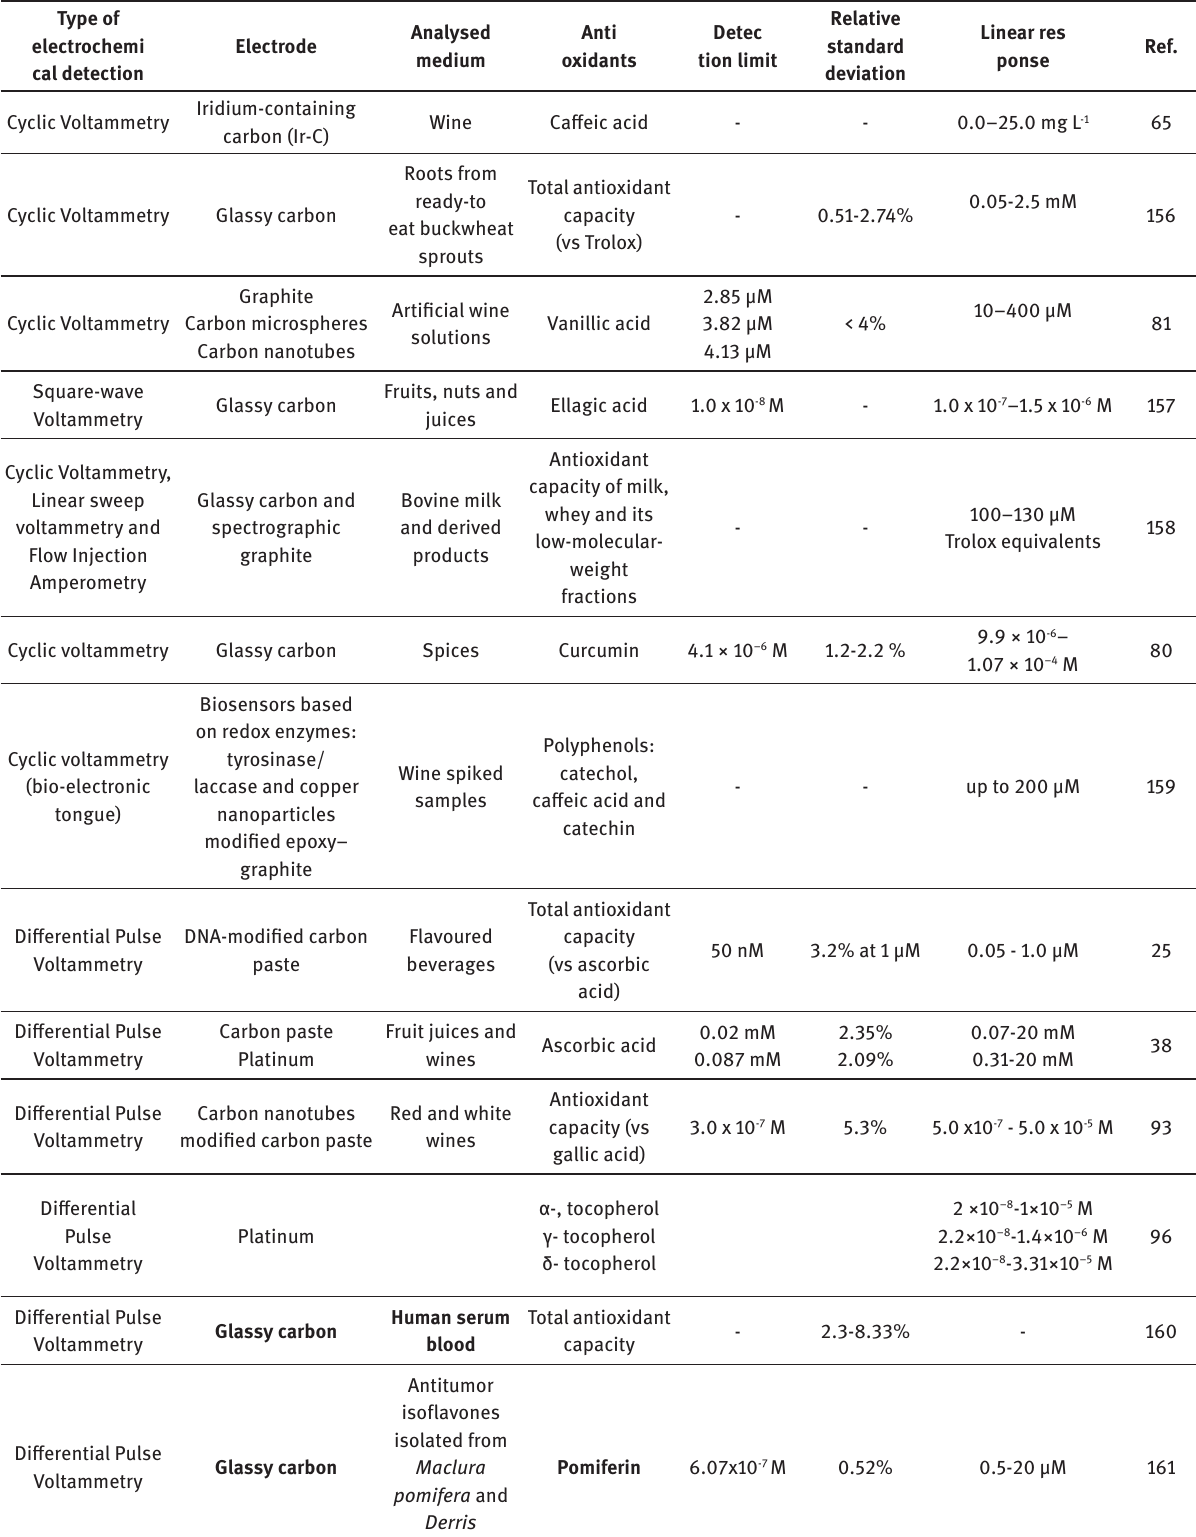
Table 1: Some analytical characteristics of the electrochemical methods applied for antioxidant and total antioxidant capacity determination Type of electrochemi cal